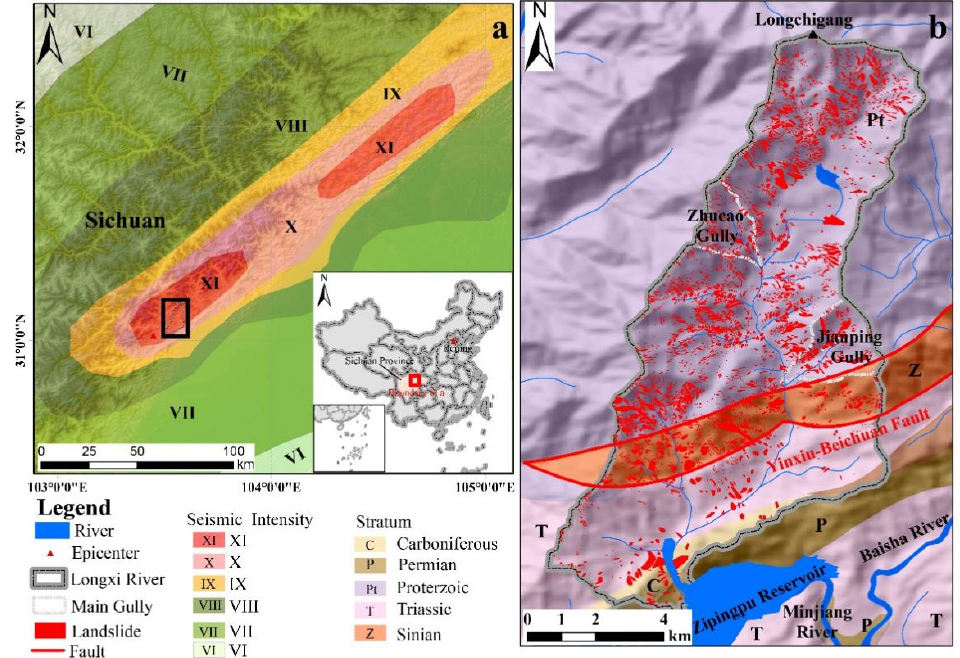
Figure 1. Location of the Longxi River: ( a ) Mapped zones of seismic intensity along the Longxi River as affected by the Wenchuan Earthquake. The black square represents the area represented within panel. ( b ) Generalized lithology, faults and the distribution of co-seismic landslides within the main study area.